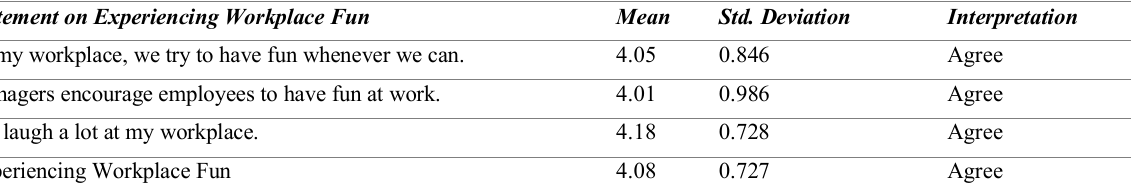
Table 4: Mean of statement on experiencing workplace fun